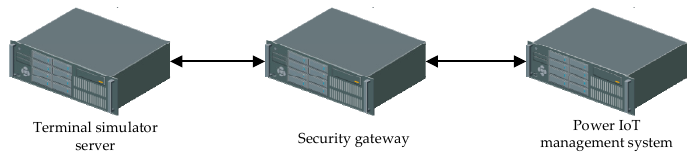
Figure 2. Network topology of the experimental evaluation.